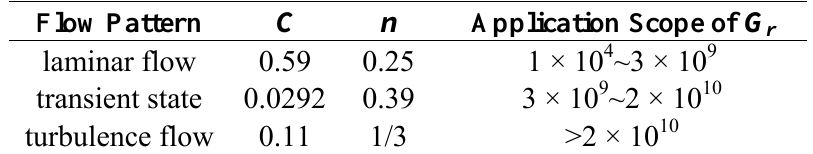
Table 2. Value of C and n for natural convection occurring on vertical plate in infinite